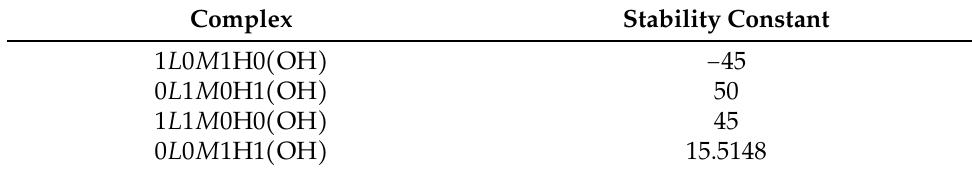
Table 4. Reaction system with extreme stability constants in decadic logarithms.